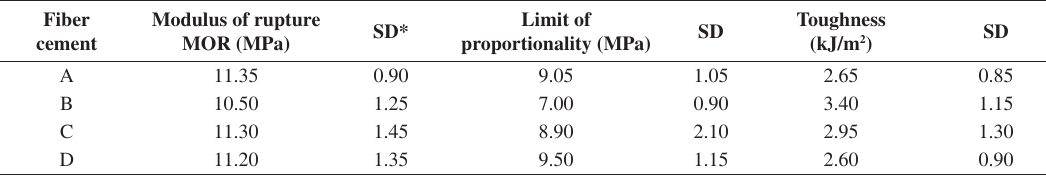
Table 9. Mechanical properties at 28 days of age. Fiber cement